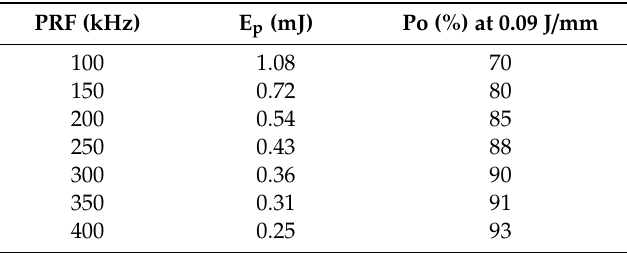
Table 2. List of parameters for investigating the influence of PRF on single-line machining at a scan speed of 1140 mm / s ( ED L = 0.09 J /